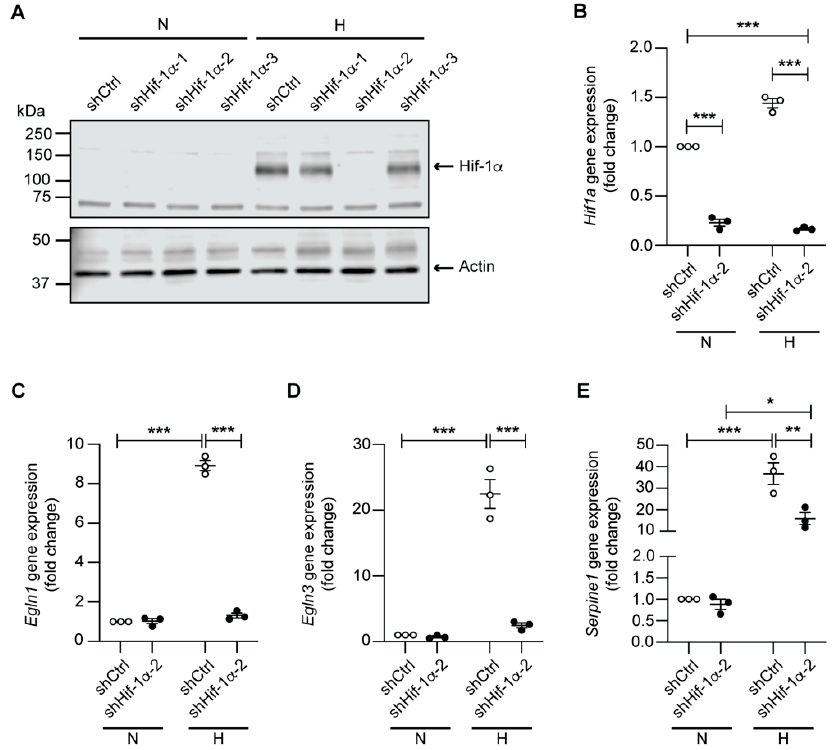
Figure 4. shRNA-mediated knockdown of Hif-1 α leads to a down-regulation of hypoxic marker genes. ( A ) Representative immunoblot of Hif-1 α in mCCD cl1 cells transduced with a control shRNA (shCtrl) and three different shRNAs targeting Hif-1 α (shHif-1 α − 1-3) in normoxia (N) or following 24 h of hypoxia (H). β − actin was used as loading control. Relative mRNA expression levels of ( B ) Hif1a , ( C ) Egln1 , ( D ) Egln3 , and ( E ) Serpine1 in mCCD cl1 cells transduced with a control shRNA (shCtrl) and a shRNA targeting Hif-1 α (shHif-1 α − 2) in normoxia (N) or following 24 h of hypoxia (H) ( n = 3 per condition). * p < 0.05, ** p < 0.01, *** p < 0.001.